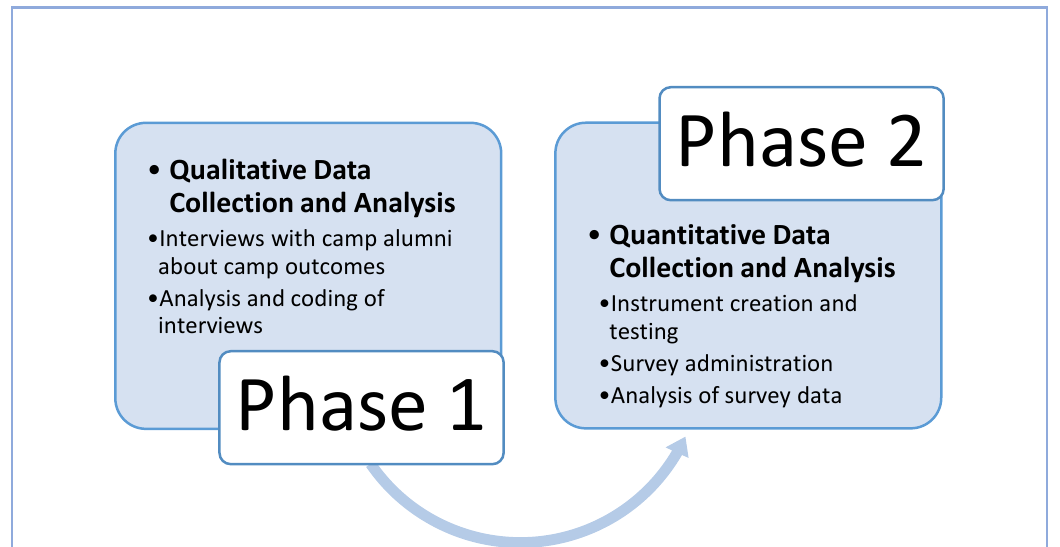
Figure 1. Exploratory Sequential Mixed Methods Design in This